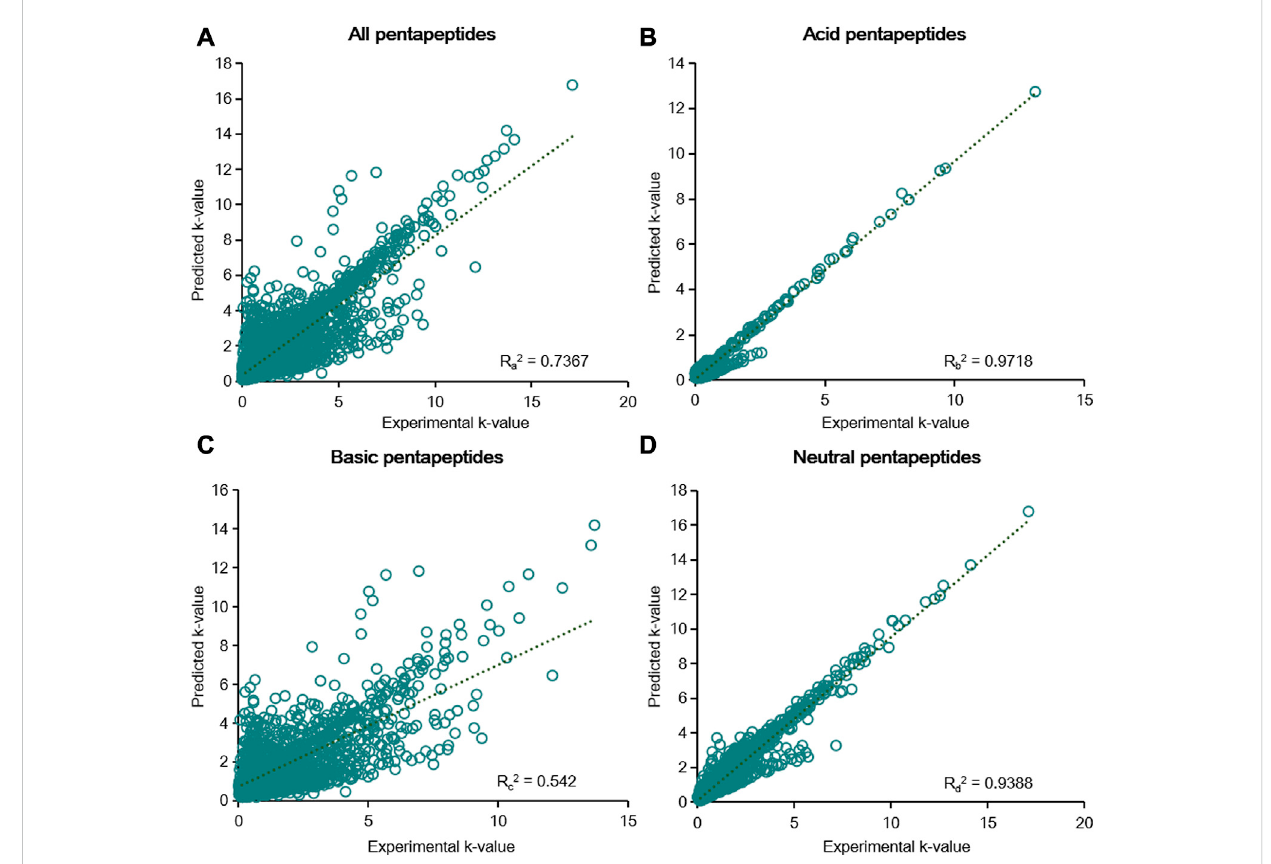
FIGURE 5 Linear fi tting resultsofthepredictedk-valueand experimentalk-value forall pentapeptides (A) , acidpentapeptides (B) , basicpentapeptides (C) ,and neutral pentapeptides (D) in the six-parameter model of φ and